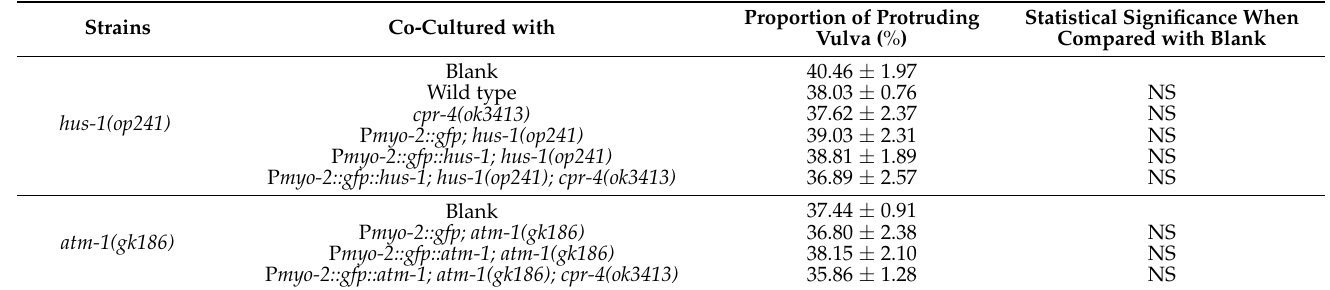
Table A2. The proportions of protruding vulva of worms co-cultured with various strains were